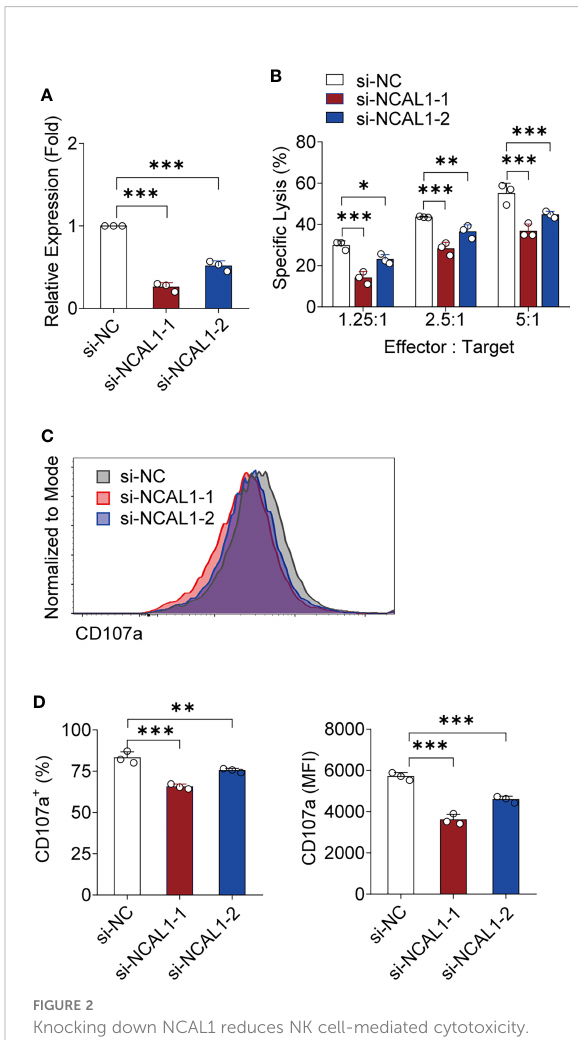
DC FIGURE 2 Knocking down NCAL1 reduces NK cell-mediated cytotoxicity. (A) siRNA-mediated NCAL1 knockdown in NK92MI cells. si- NCAL1-1 and si-NCAL1-2: siRNAs targeting NCAL1; si-NC: random siRNA control. *** p < 0.001, one-way ANOVA. (B) Cytotoxicity mediated by NCAL1-knockdown NK92MI cells at various effector cell:target cell ratios, as detected by calcein- release assays. Data represent three independent experiments. * p < 0.05, ** p < 0.01, *** p < 0.001, two-way ANOVA. (C) Representative fl ow cytometry analysis of CD107a expression in NCAL1 knockdown NK92MI cells. (D) Statistical analyses of percentages and mean fl uorescence intensity (MFI) of CD107a expression in NCAL1 knockdown NK92MI cells. Data represent three independent experiments. ** p < 0.01, *** p < 0.001, one- way